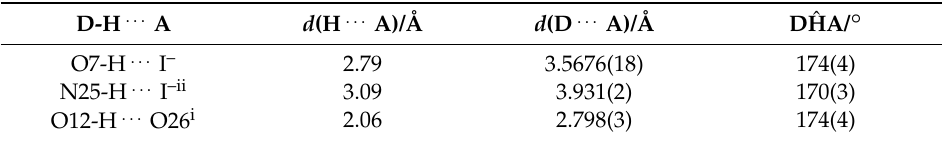
Table 3. The hydrogen bond geometries found in the crystal structure of 1 , D being the donor and A being the acceptor. Symmetry codes: (i) x – 1 / 2 , –y + 1 / 2 , –z + 1; (ii) –x + 2, y + 1 / 2 , –z + 1 / 2